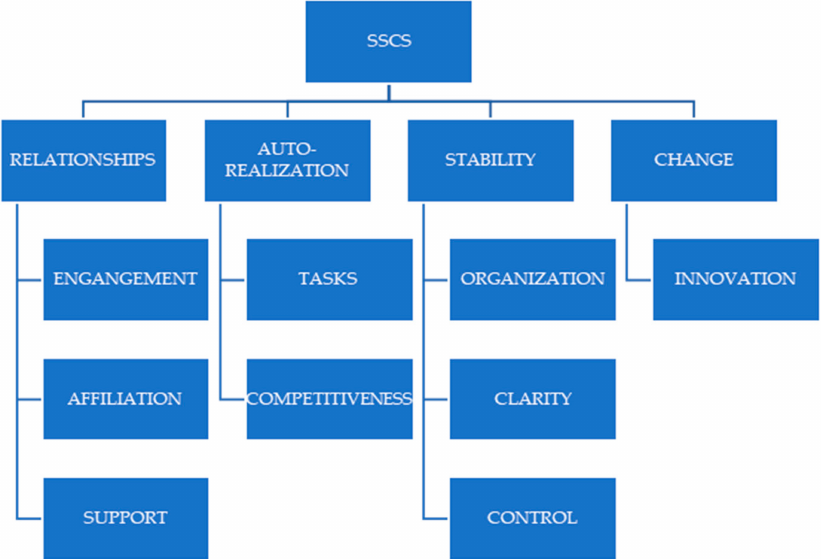
Figure 1. The School Social Climate Scale (SSCS).